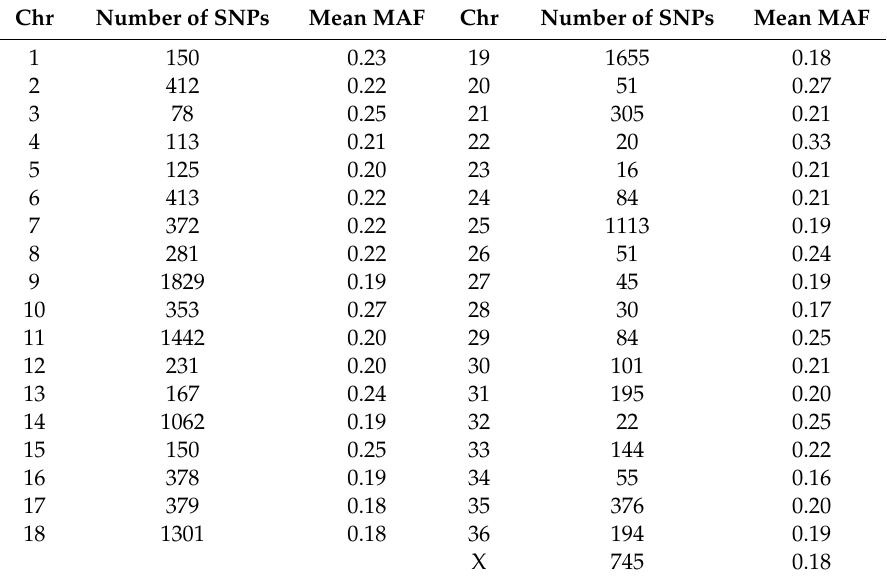
Table 1. Genome-wide summary of